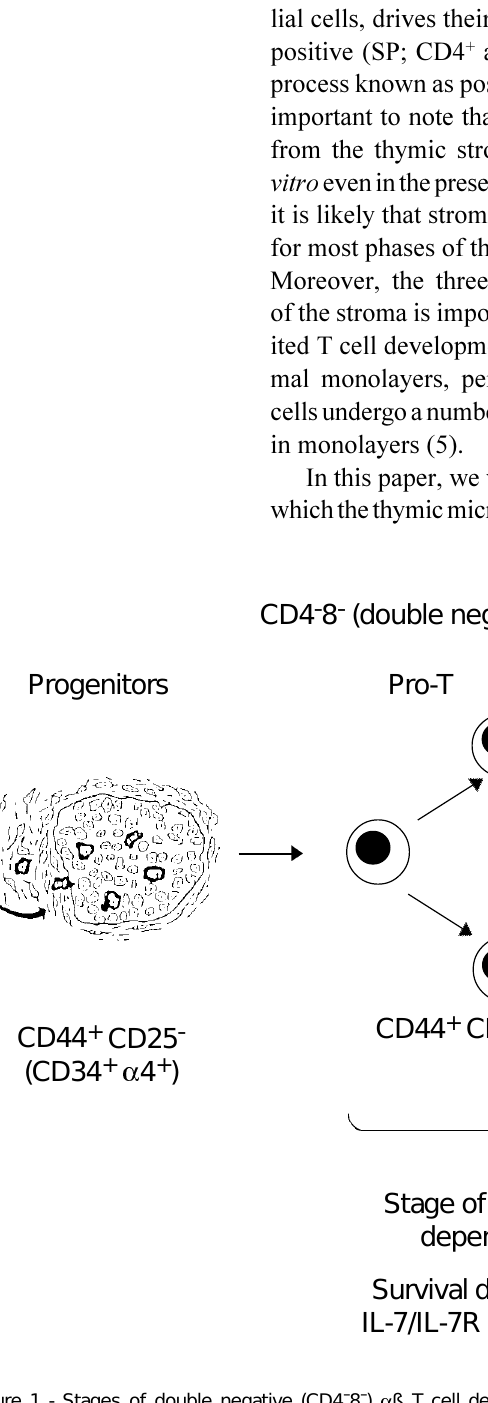
Figure 1 - Stages of double negative (CD4 - 8 - ) a ß T cell development. The CD44 + stage requires both fibroblast/ECM interactions with developing thymocytes as well as IL-7/IL-7R